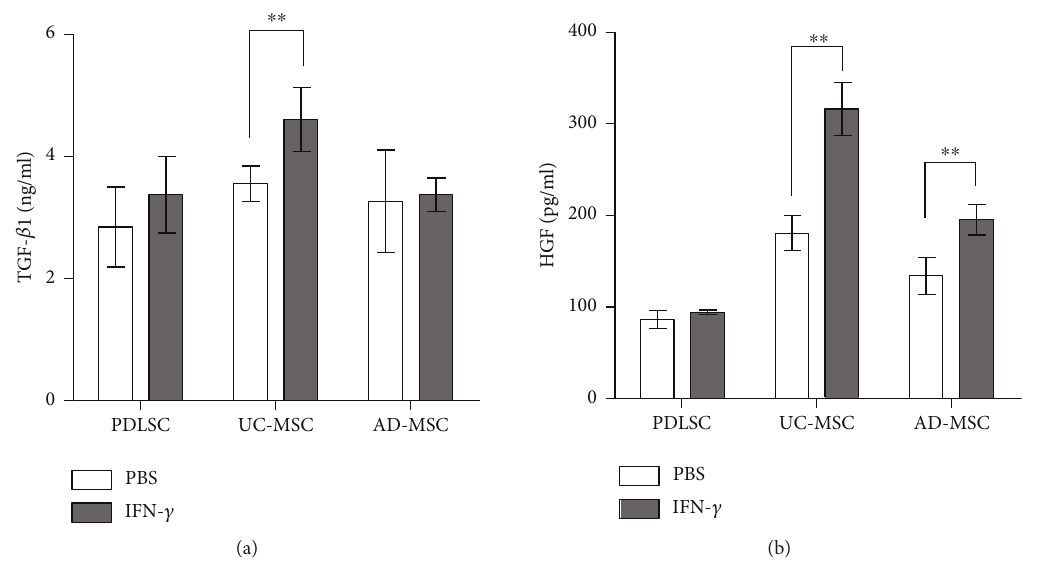
Figure 4: Secretion of immunosuppressive cytokines in MSCs. MSCs were cultured for 48 hours in the presence or absence of 10ng/mL IFN- γ . Culture supernatants were subjected to ELISA for (a) TGF- β 1 and (b) HGF using commercial ELISA kits. All experiments were performed three times, and duplicated samples from each experiment were measured. The graph shows the means and SEMs. p values were obtained by Kruskal-Wallis one-way analysis of variance. ∗ p < 0 05 and ∗∗ p < 0 01